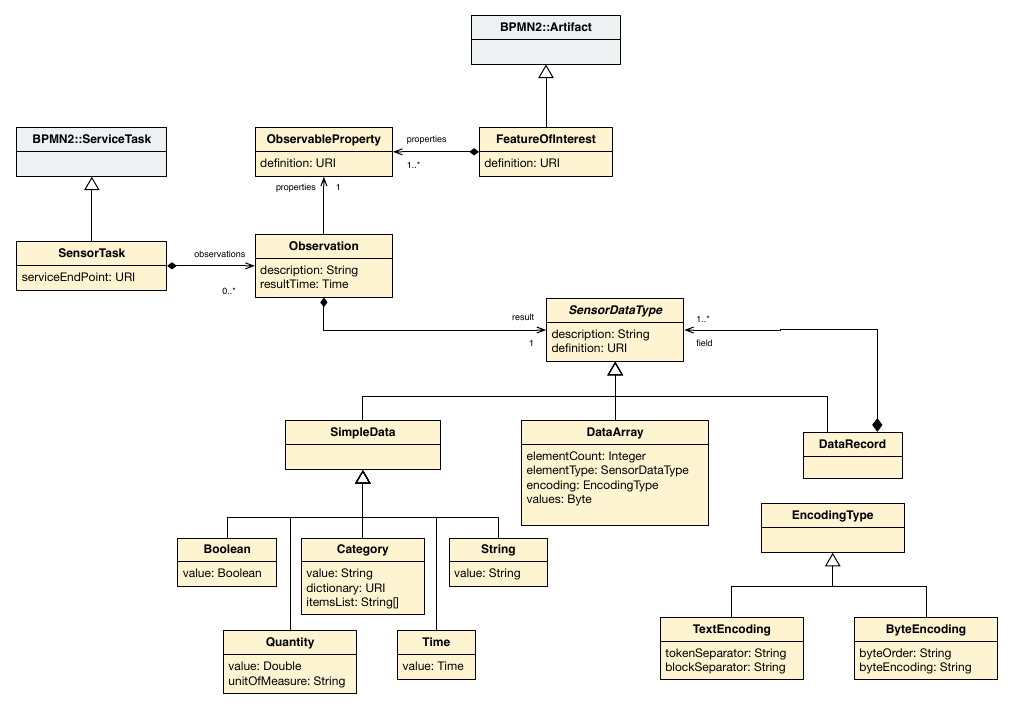
Figure 6. IoT-BPMN Metamodel